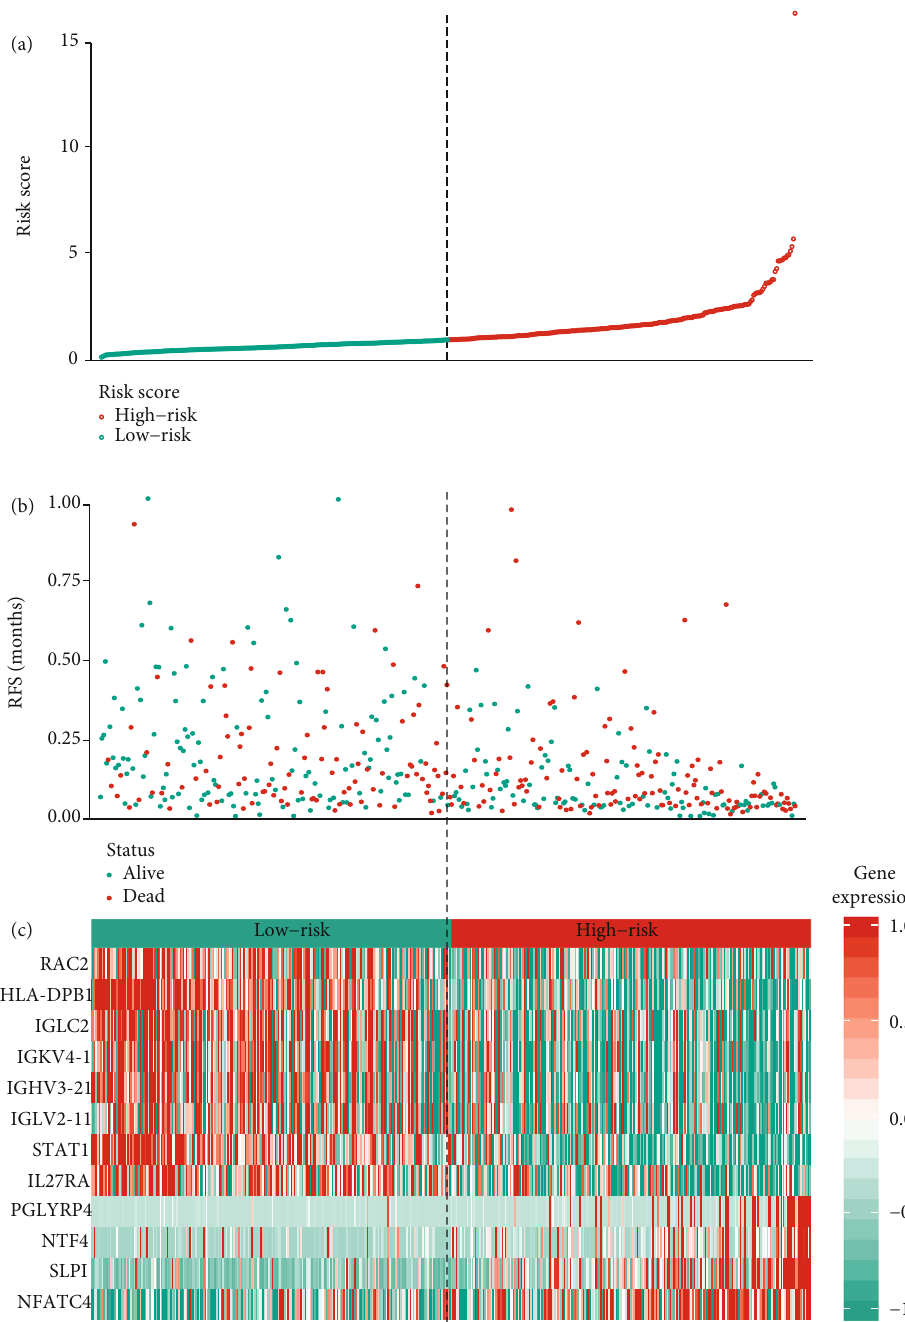
Figure 2: Establishment of a risk model: (a, b) vital status of patients based on the risk score; (c) the expression of identi fi ed hub immune signatures between low- and high-risk